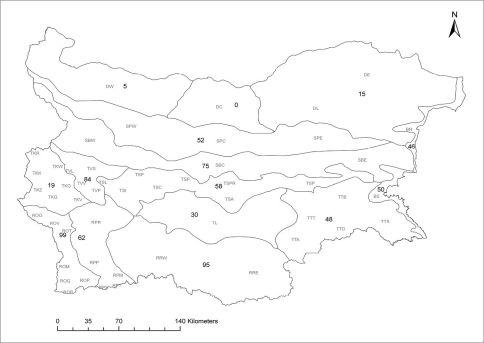
Total number of ant species for separate regions and subregions